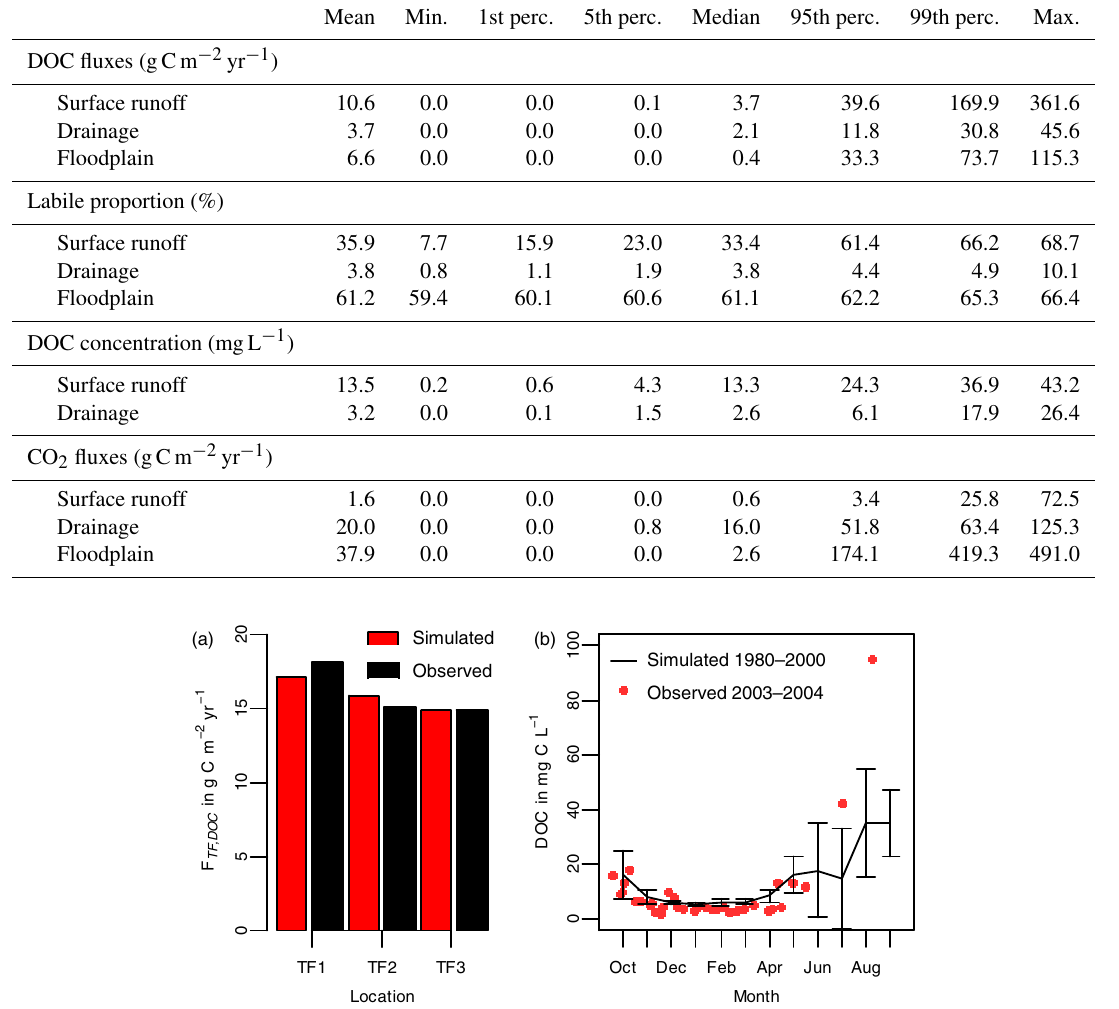
Table 8. Statistical distributions of simulated export fluxes and concentrations within the Amazon basin. Mean Min. 1st perc. 5th perc. Median 95th perc. 99th perc. Max.